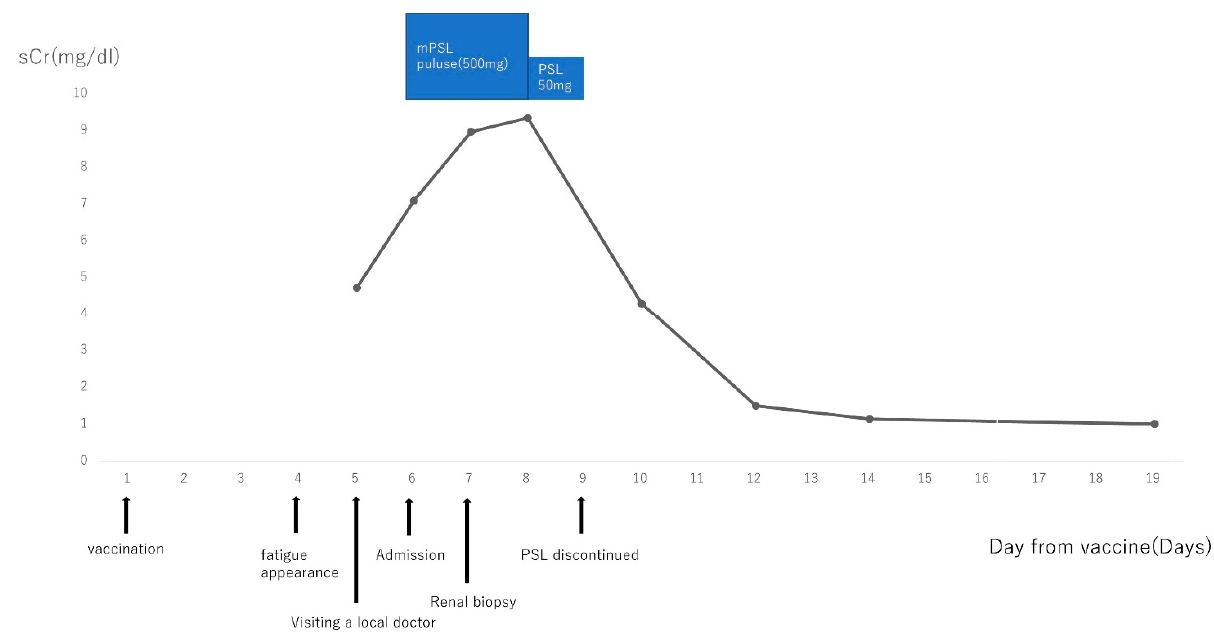
Figure 2. A chart of the treatment process. Rapidly progressive glomerulonephritis was suspected, and an initial treatment with methylprednisolone pulse therapy was given. After the renal biopsy results revealed acute tubular injury as the sole pathology, steroid treatment was discontinued. Eventually, renal function began to improve, and the serum creatinine level returned to baseline. sCr, serum creatinine; mPSL, methylprednisolone; PSL, prednisone